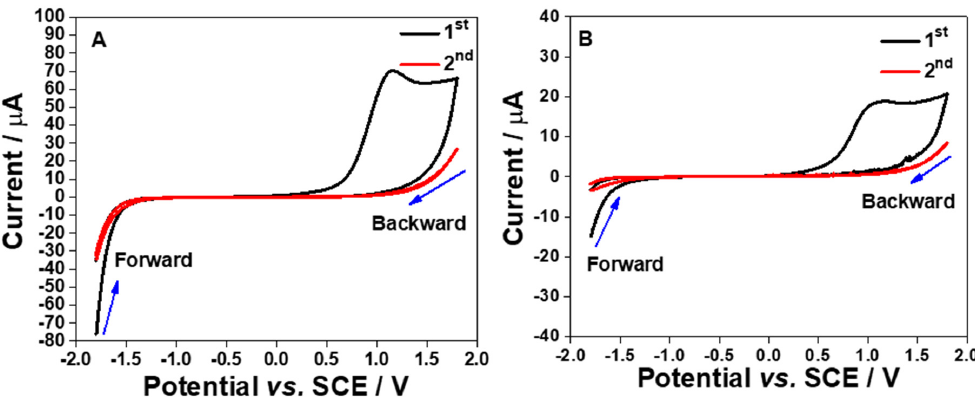
Figure 4. Cyclic voltammograms (1st and 2nd cycles) of the S1 ( A ) and S2 ( B ) electrodes in a purged PB solution (pH 7, 0.1 M) at 100 mV s − 1 . The potential was cycled from − 1.8 to 1.8 V vs. SCE. From the CVs, the hydrogen evolution reaction (HER) starts at − 1.5 V vs. SCE for both electrodes.